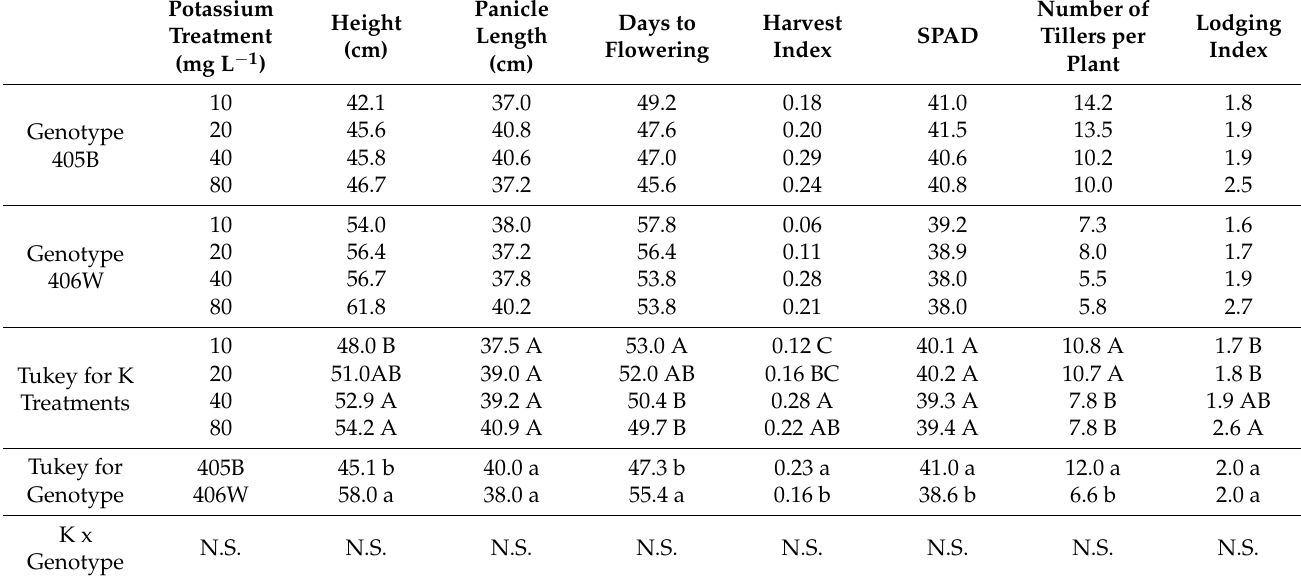
Table 2. Effect of K fertigation levels on growth parameters in the winter pot experiment. Different letters represent significant (<0.05) differences for main effects. Upper case letters next to the values in the 3rd row represent the results of the Tukey test for nutrient concentration averaged across genotypes, and lower case letters next to the values in the 4th row represent the results of the Student- t test for the two different